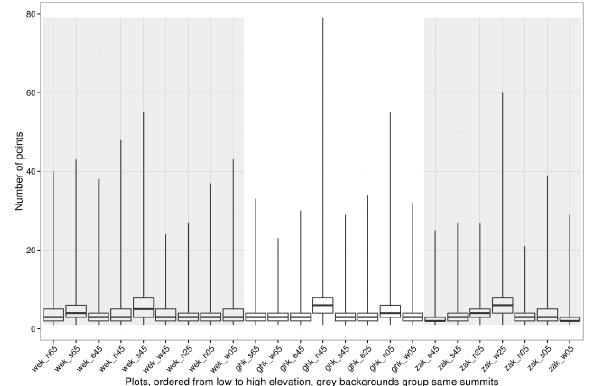
Figure 7. Distribution of point counts per 6 mm cell per plot. Vertical lines represent the range of absolute values, horizontal lines are the median values and the box margins are the 25 th and 75 th quantile. Plot names are abreviations for the summit, the cardinal direction and altitude below the HSP.